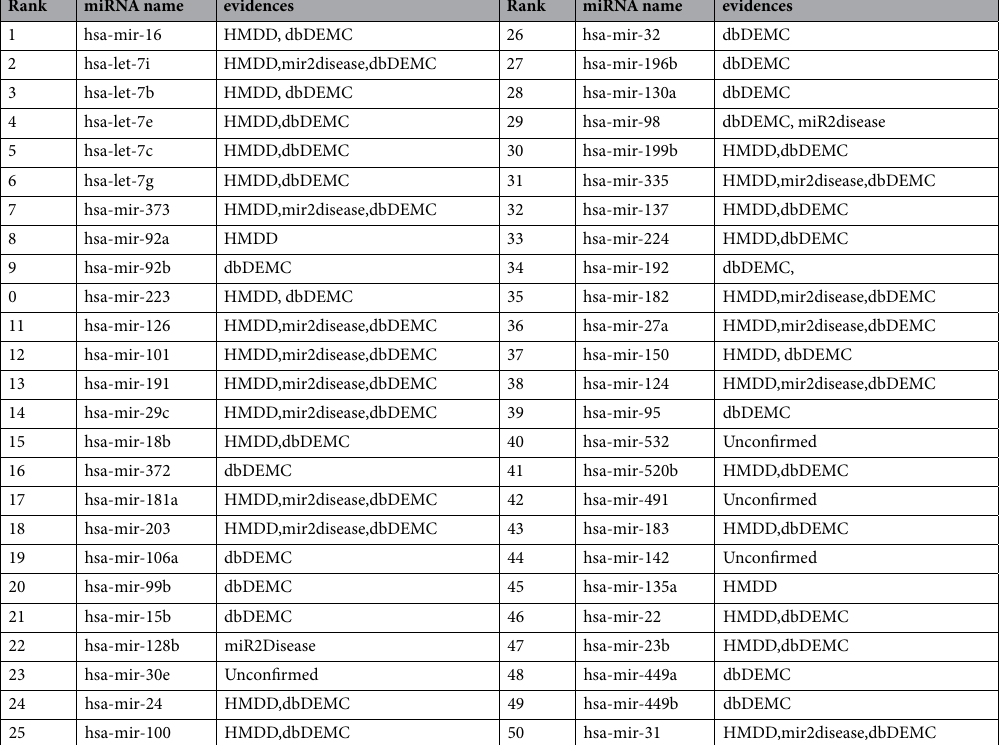
Table 1. The top 50 breast cancer-related miRNAs candidates predicted by GSTRW and the confirmation of these associations. Forty-six of the top 50 potential breast cancer miRNAs candidates have been confirmed based on the update HMDD, dbDEMC and